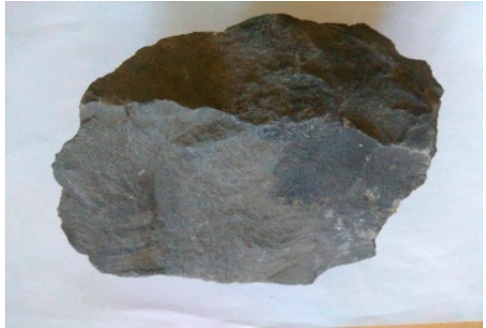
Figure 2. Basalt rock from open-pit mine (photo by K. Se ń czuk).